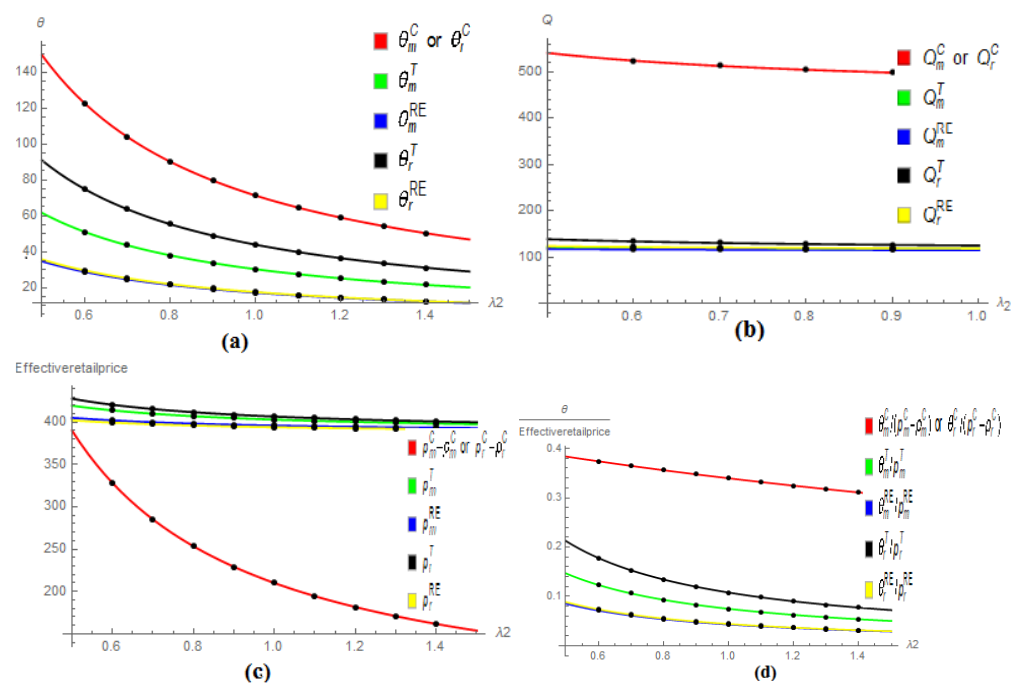
Figure 1. Graphical representation of ( a ) greening levels, ( b ) sales volumes, ( c ) effective retail prices, and ( d ) ratio of greening levels with effective retail prices in Scenarios MC, RC, MRE, RRE, MT, and